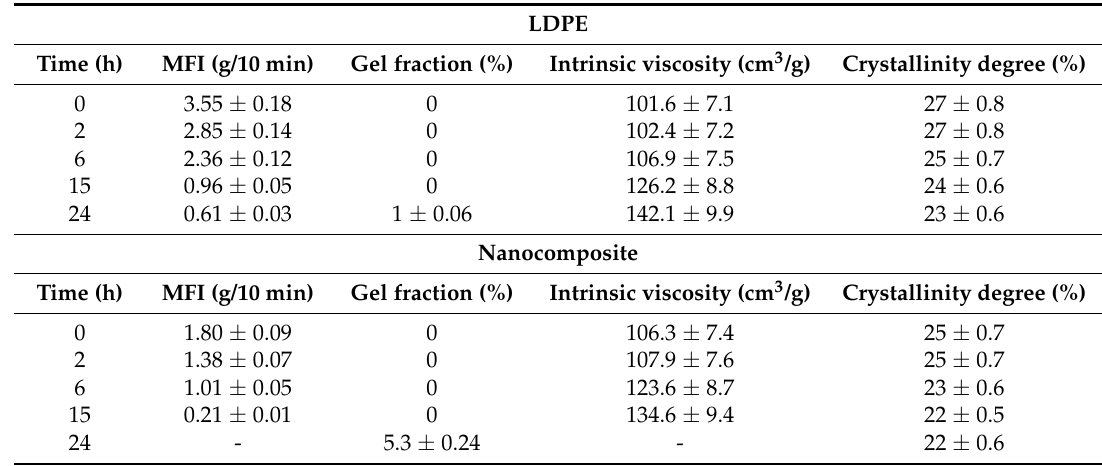
Table 1. MFI, intrinsic viscosity, gel fraction, crystallinity degree, and absorbance ratio of irradiated samples at given exposure times for LDPE and nanocomposite